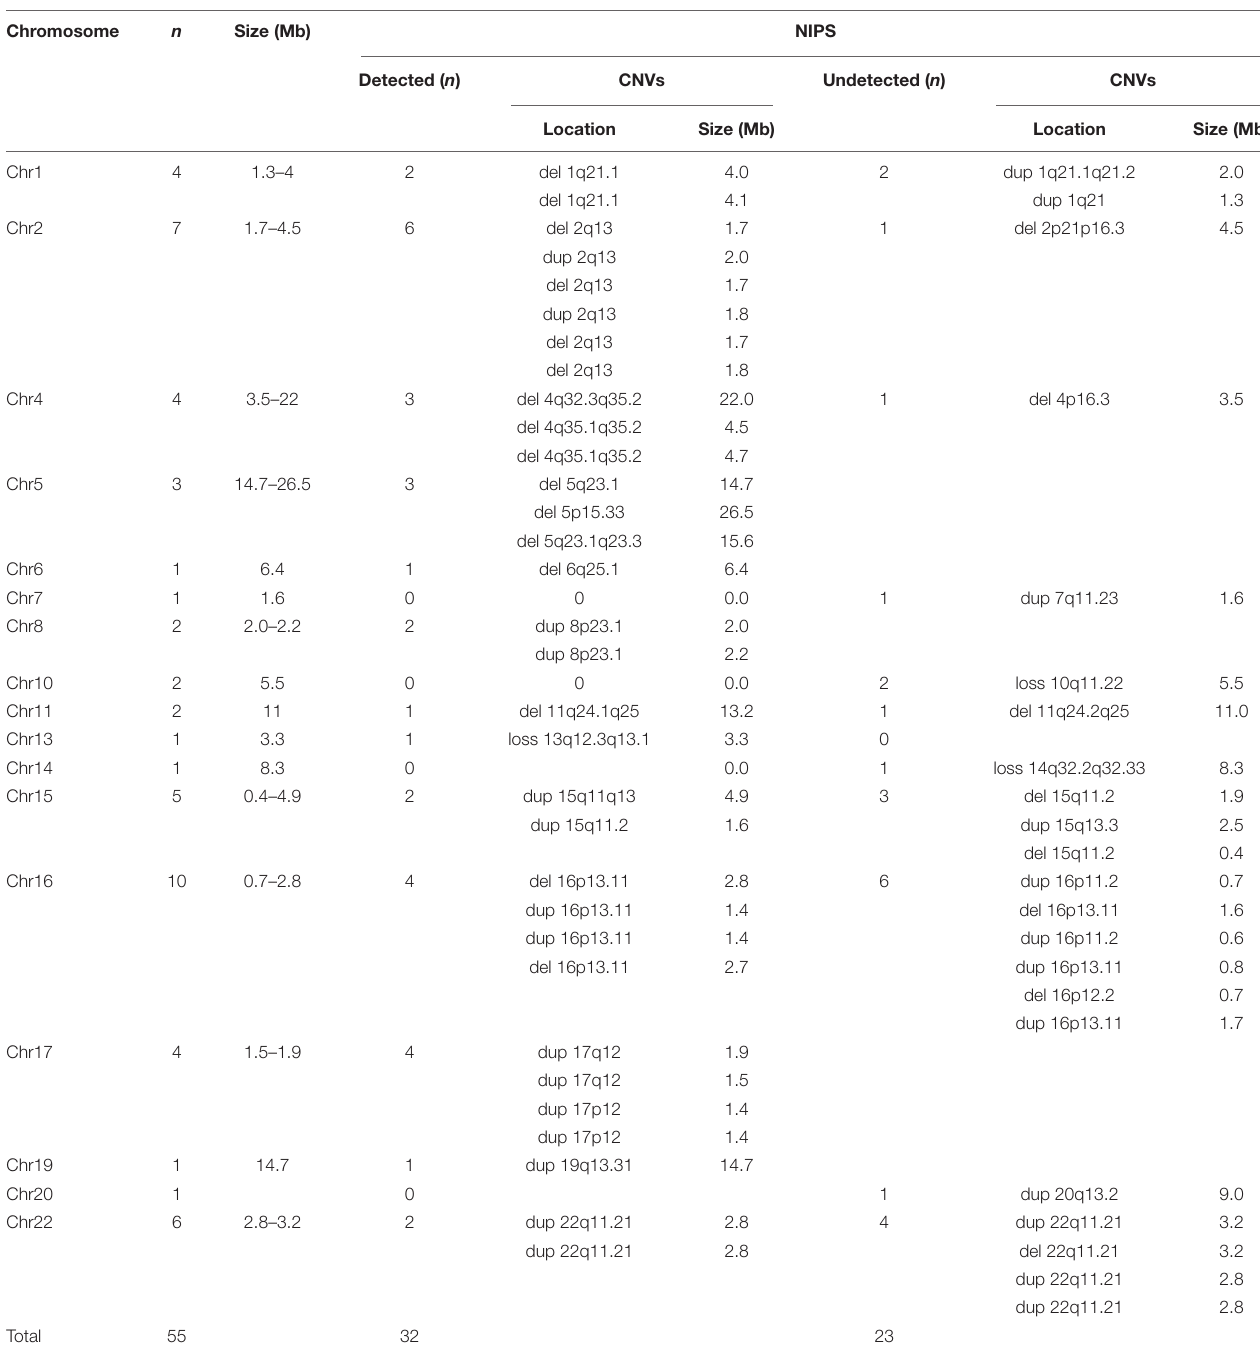
TABLE 5 | Detailed information regarding fetal CNVs in this study (detected or not detected by NIPS).